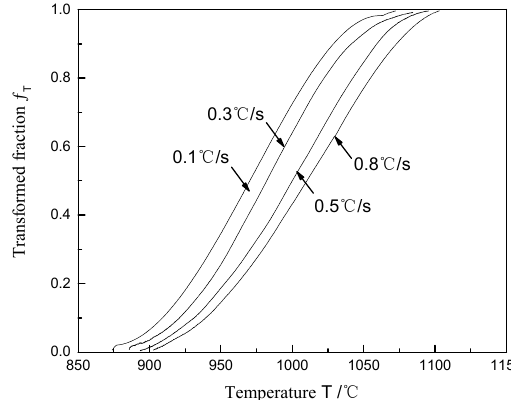
Figure 5. The relationship between the transformed fraction and heating temperatures at different heating rates.